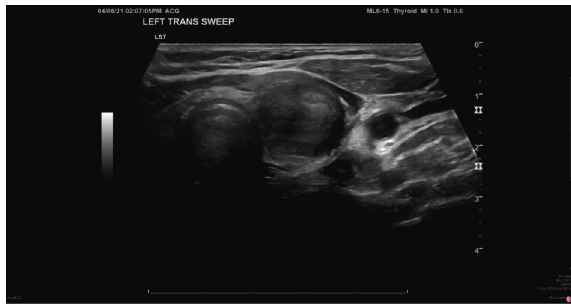
Figure 2: Ultrasound of the left thyroid lobe showing a hetero- geneous